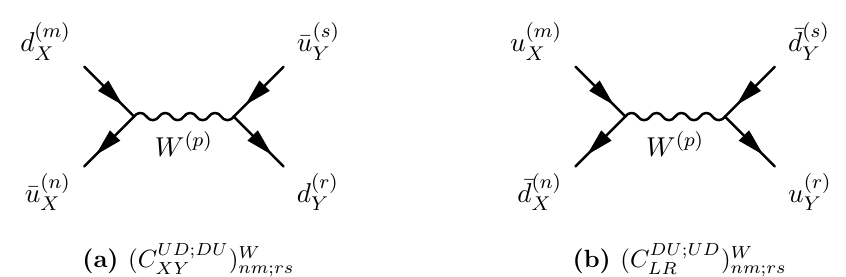
Figure 7. The Feynman diagrams that give rise to the e(cid:11)ective 4-fermion interactions discussed in eq. (6.46). Here, W ( p ) denotes the p th KK mode of a W (cid:6) vector gauge boson, and X and Y are chiralities (i.e., X = L; R and Y = L; R